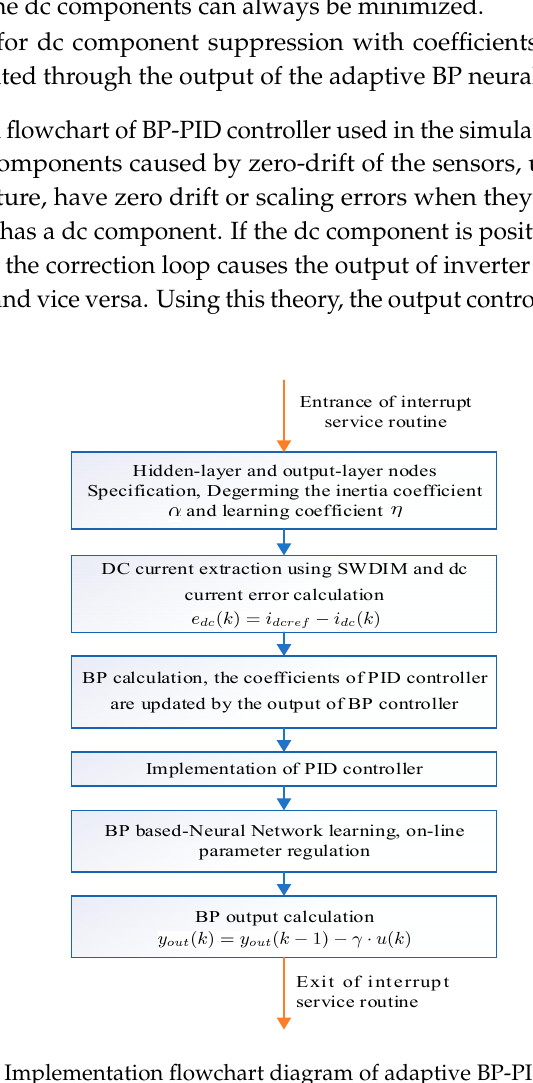
Figure 4. Implementation flowchart diagram of adaptive BP-PID controller.